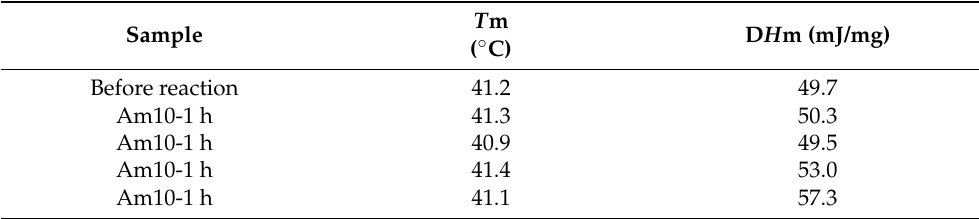
Table 2. Thermal properties of the materials from different reaction times.